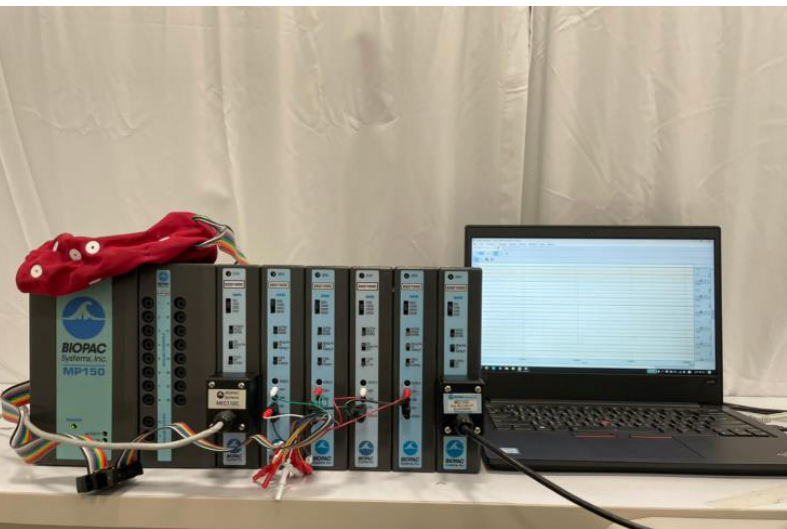
Figure 8. MP-150 (Bipac system) physiological signal measuring instrument: connect to a computer via a local area network (LAN), and you can connect to different physiological signal amplifiers by yourself. The sampling frequency can be as high as 200 Hz. The signal processed by the amplifier is very weak, so it needs to be amplified (1 Mv × 1000 times = 1 V) before it is easy to record and analyze the signal clearly.